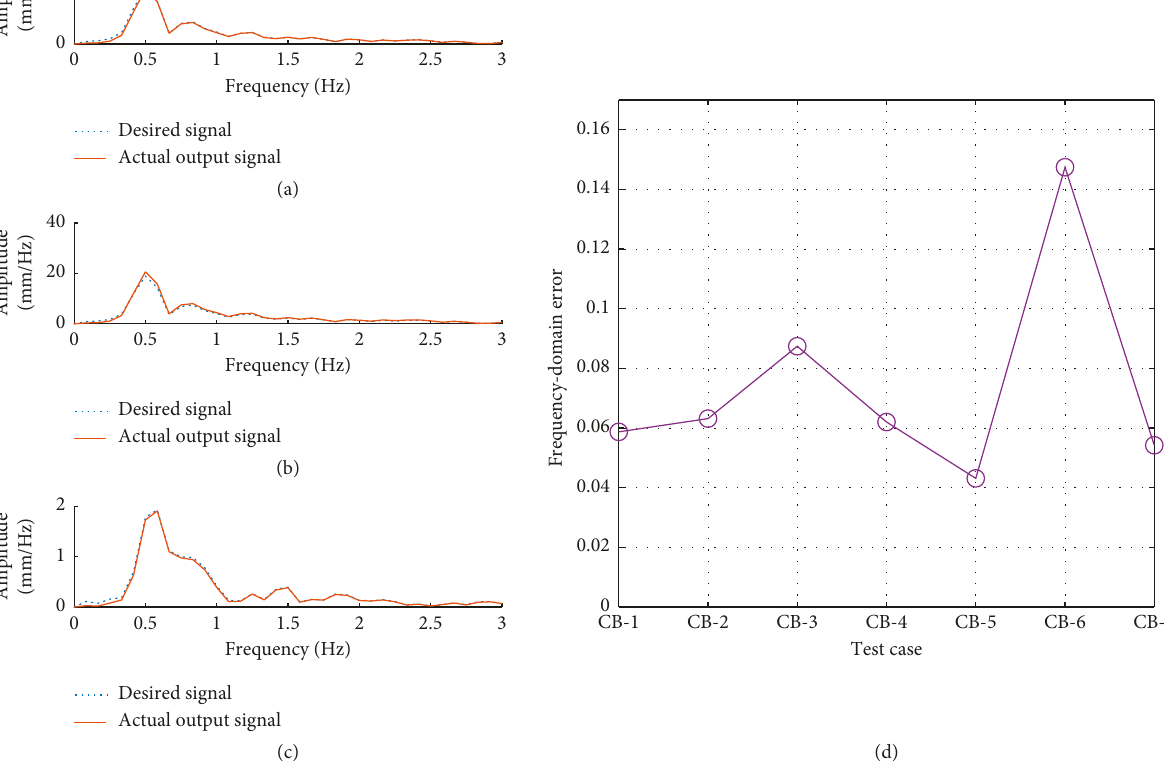
Figure 24: Desired signal and actual output signal frequency-domain comparison and error. (a) Case CB-1; (b) case CB-3; (c) case CB-5; (d) frequency-domain error of test cases.